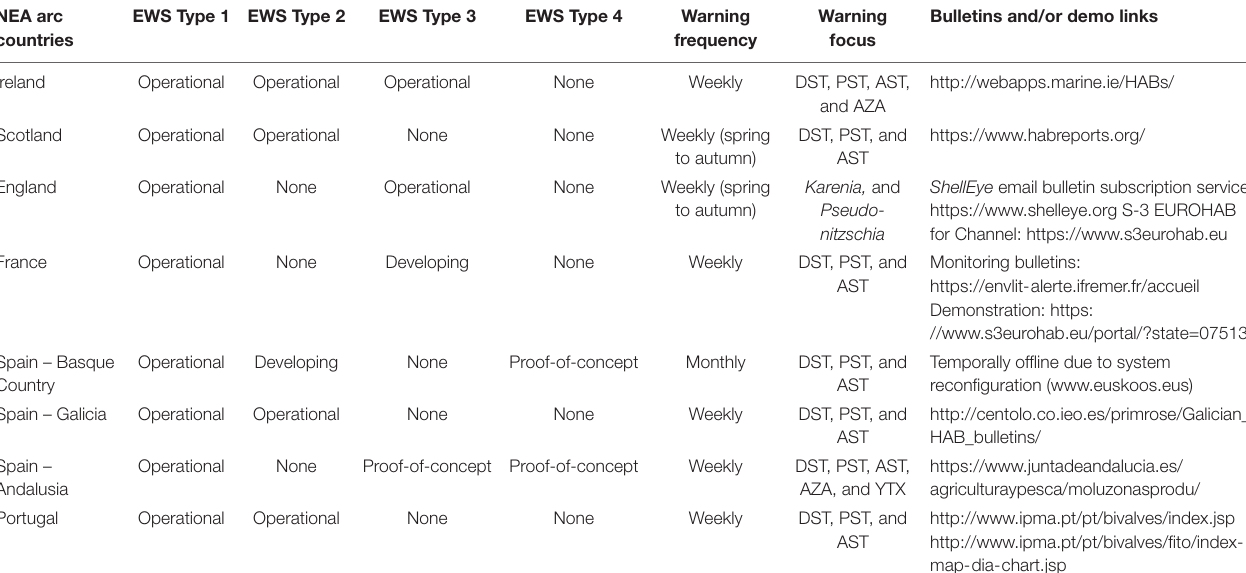
TABLE 5 | EWS for HABs and Biotoxins in the Atlantic arc regions: features and components. NEA arc